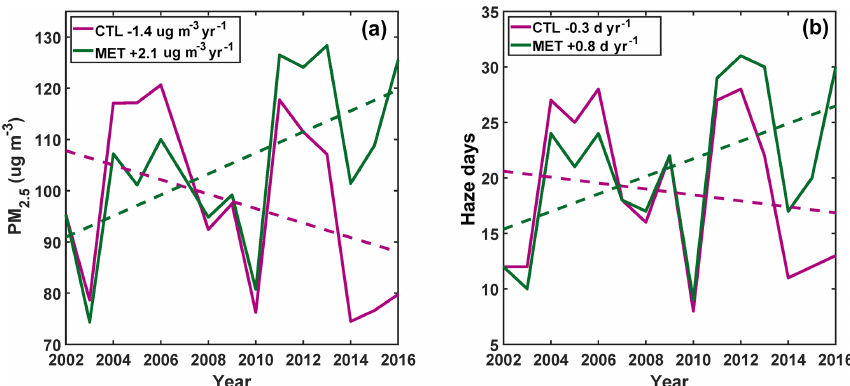
Figure 4. Wintertime mean concentrations of PM 2 . 5 and number of haze days (defined as daily mean concentration above 150µgm − 3 ) from the CTL and MET simulations.